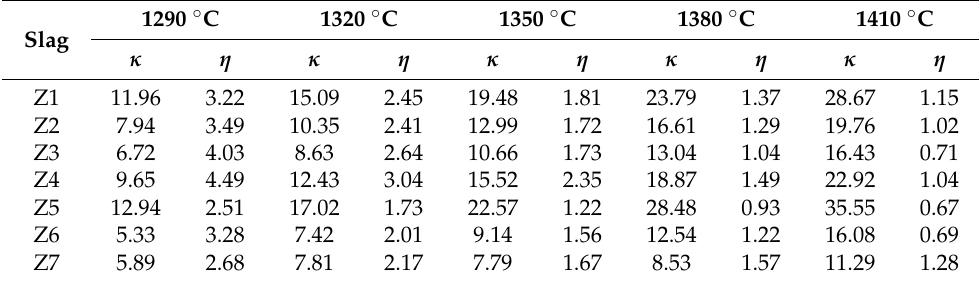
Table 2. Measured viscosity (Pa · s) and conductivity (S/m) of slags at different temperatures ( ◦ C). 1290 ◦ C 1320 ◦ Slag